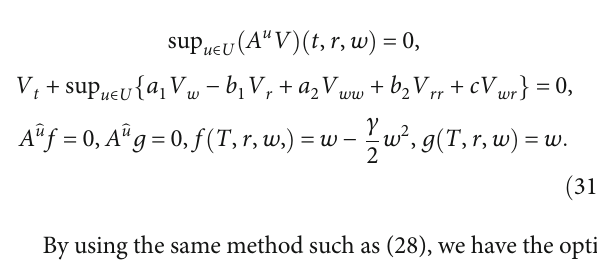
Table 1: The value of